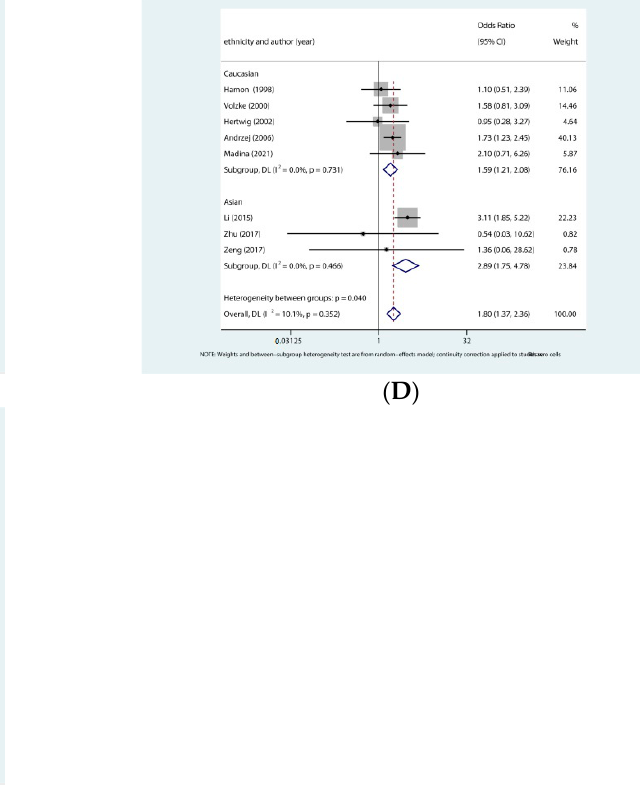
Figure 3. Subgroup meta-analysis by ethnicity of the association of the rs5186 polymorphism and risk of restenosis after PCI. ( A ) allele model: C vs. A; ( B ) homozygote model:CC vs. AA; ( C ) heterozygote model: AC vs. AA; ( D ) recessive model: CC vs. AC + AA; and ( E ) dominant model: CC + AC vs. AA. CI = confidence interval, OR = odds ratio [13–20].